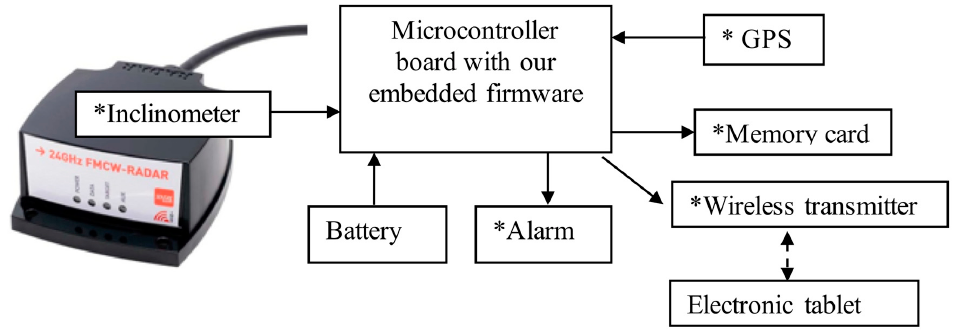
Figure 5. Assembly block diagram for controlling and operating the radar. * Optional, depends on the final application.